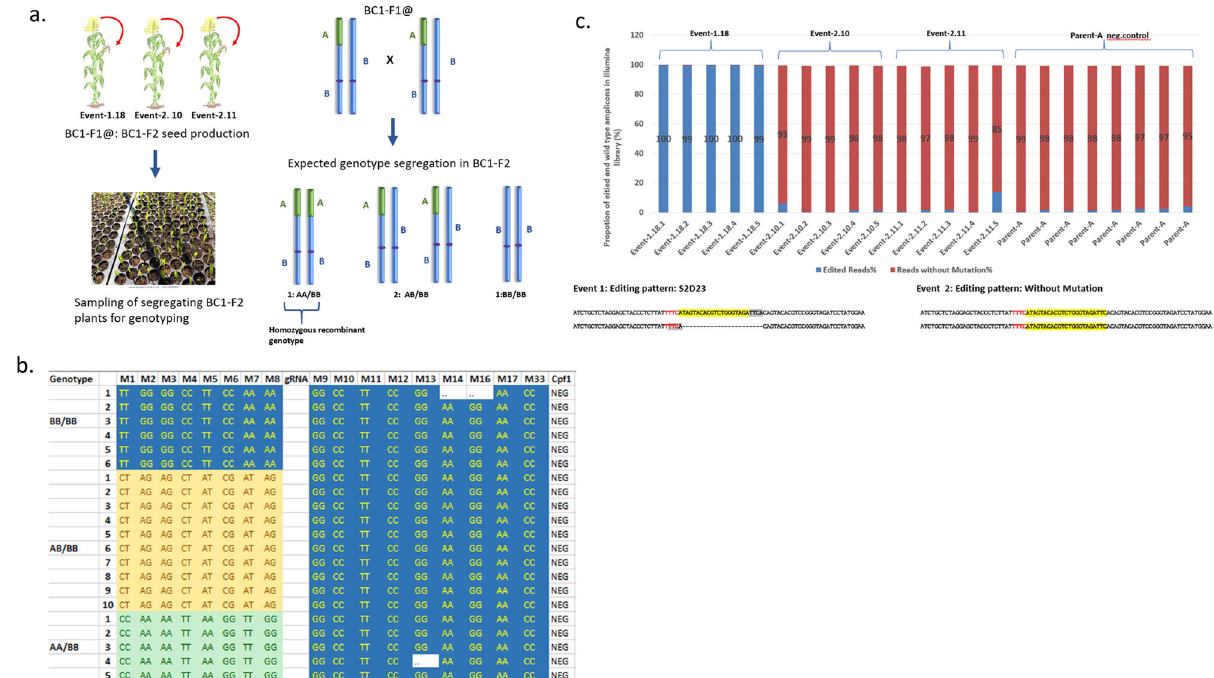
Fig. 4 Segregation analysis of BC1-F2 populations and identi fi cation of homozygous recombinant plants. a Schematic diagram of the segregation analysis of the BC1-F2 populations; b The result of the genotyping analysis of the BC1-F2 segregating population. An example of the segregation analysis of the SNP markers in 21 BC1-F2 plants from Event-2.11 is shown; c Con fi rmation of DNA editing pattern at the site of the targeted CO in homozygous BC1-F2 plants with Illumina sequencing. DNA was isolated from a single leaf disc sampled from each BC1-F2 plant for library construction and sequencing. Each bar on the graph represents a result derived from a single BC-F2 plant ( n = 1). The proportion of edited (blue) and non-edited (red) amplicons in homozygous recombinant plants from three evaluated populations is shown on the graph. The pictures under the graph represent alignments of the sequences at the site of targeted CO with the inbred reference. gRNA1 target sequence is highlighted in yellow. The gray highlights nucleotides microhomology that could contribute to the repair of DSBs. S2d23 is an abbreviated description of the DNA editing pattern. S2 indicates the nucleotide position where the deletion starts; d23 indicates the length of the deleted